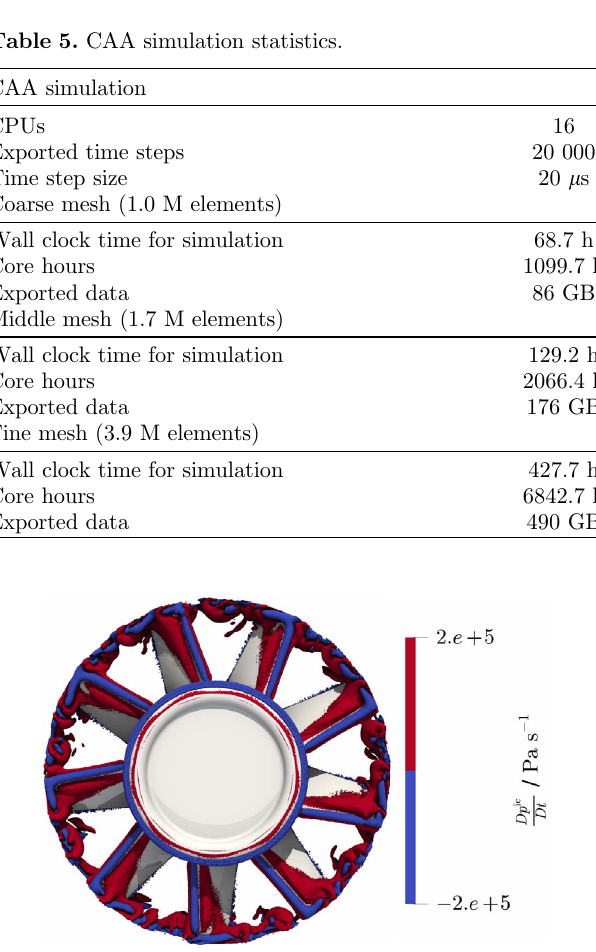
Figure 23. Acoustic sources of the PCWE equation at an instantaneous time.